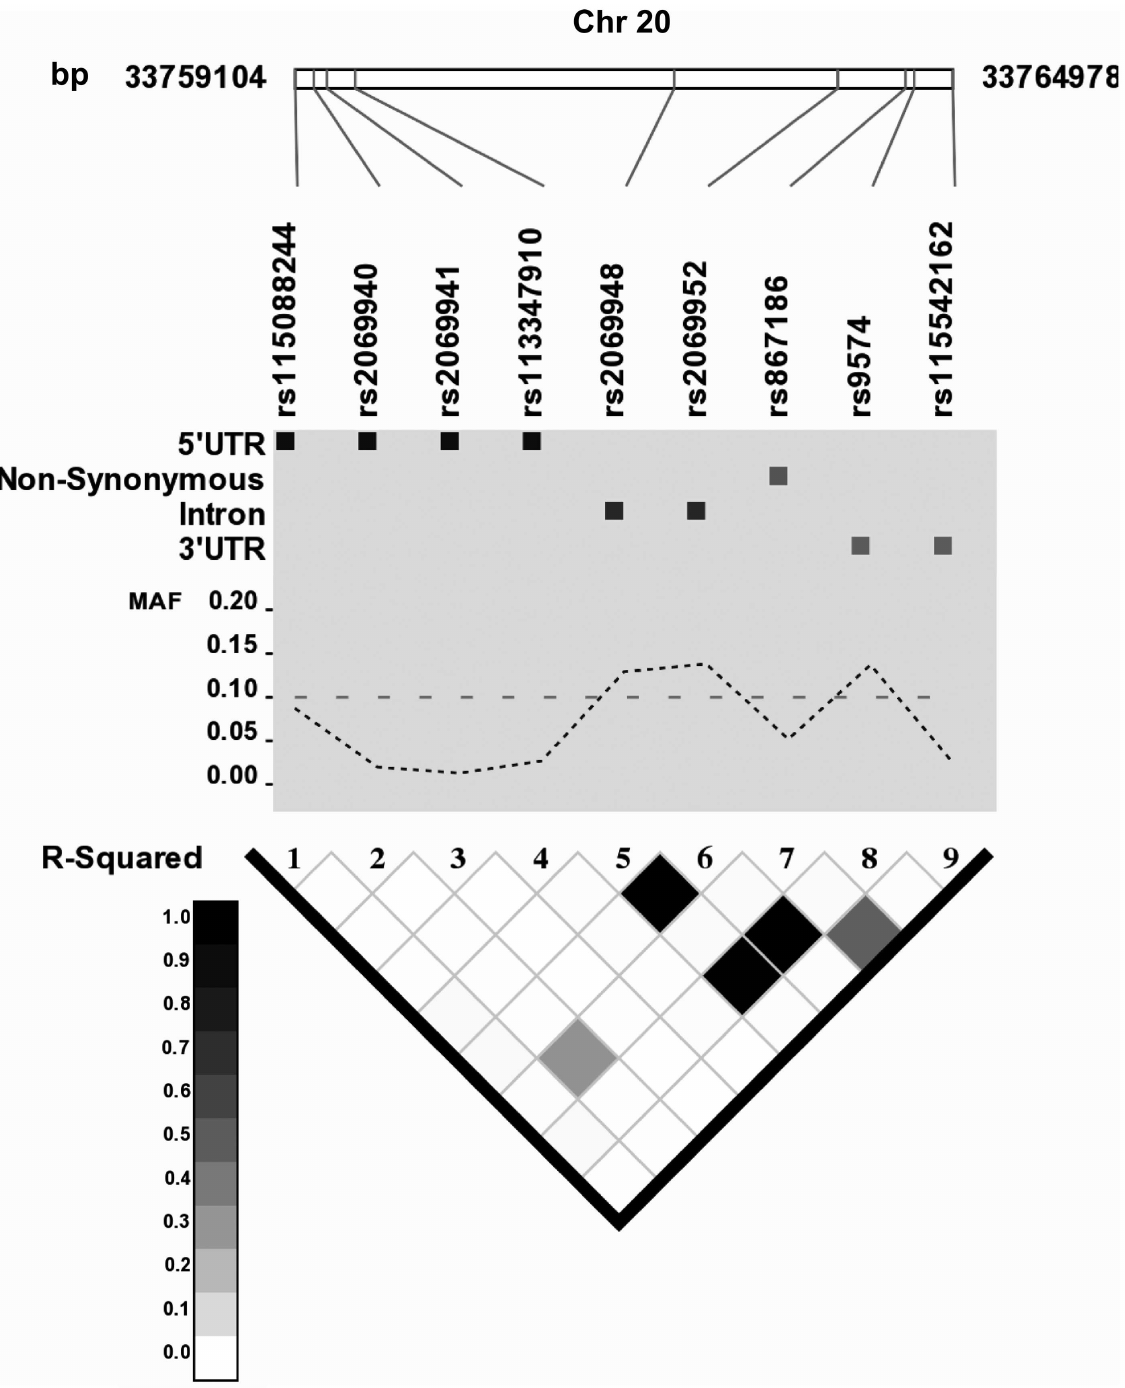
Fig. 1. Linkage disequilibrium plot of the PROCR gene locus. The plot was generated on the basis of SNPs (MAF $ 1%) in healthy control individuals. Grey-scale squares represent pairwise r 2 values ranging from 0–1.